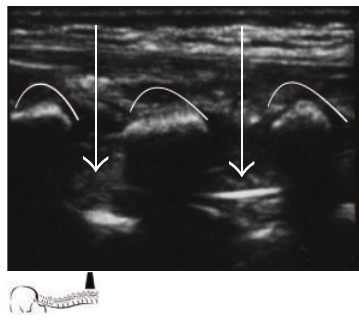
Figure 4: Longitudinal view at the thoracic spine level, viewing the advancement of the caudal epidural catheter. Curved lines show spinous processes. Arrows show epidural catheter in between spinous